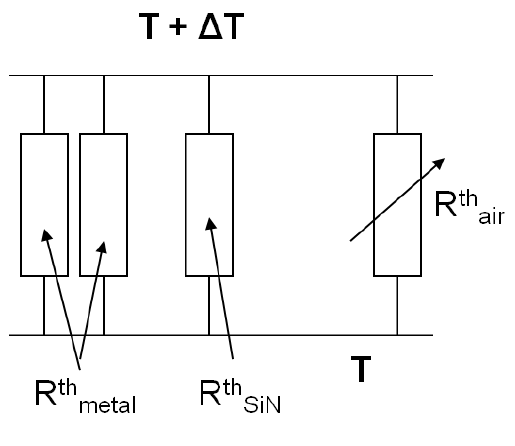
Figure 5. Equivalent thermal resistance network of the Pirani